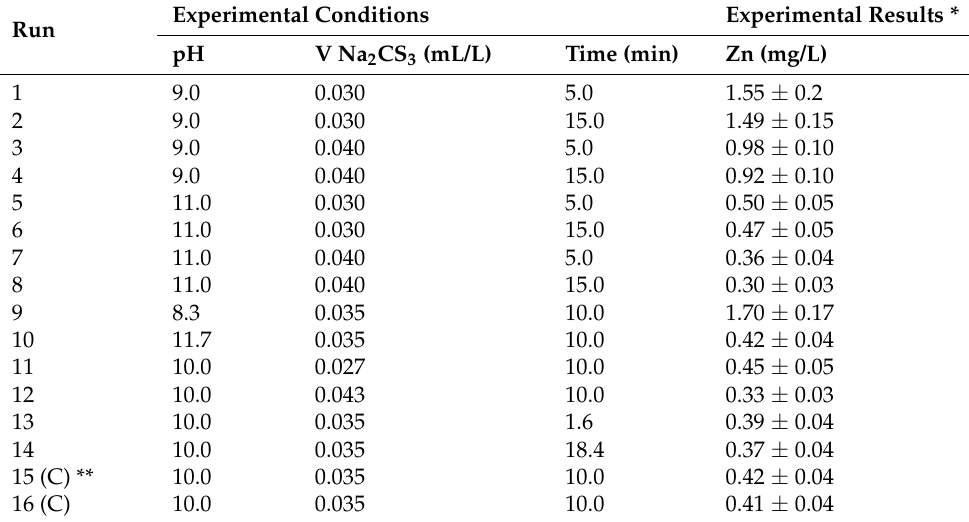
Table 3. The experimental conditions for the CCD/RSM and results (Zn, mg/L) for the treated galvanic wastewater. Experimental Conditions Experimental Results * Run